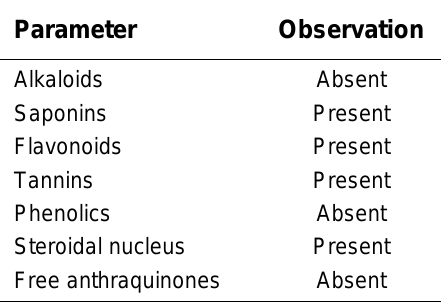
Phytochemistry of Stem Bark of C.